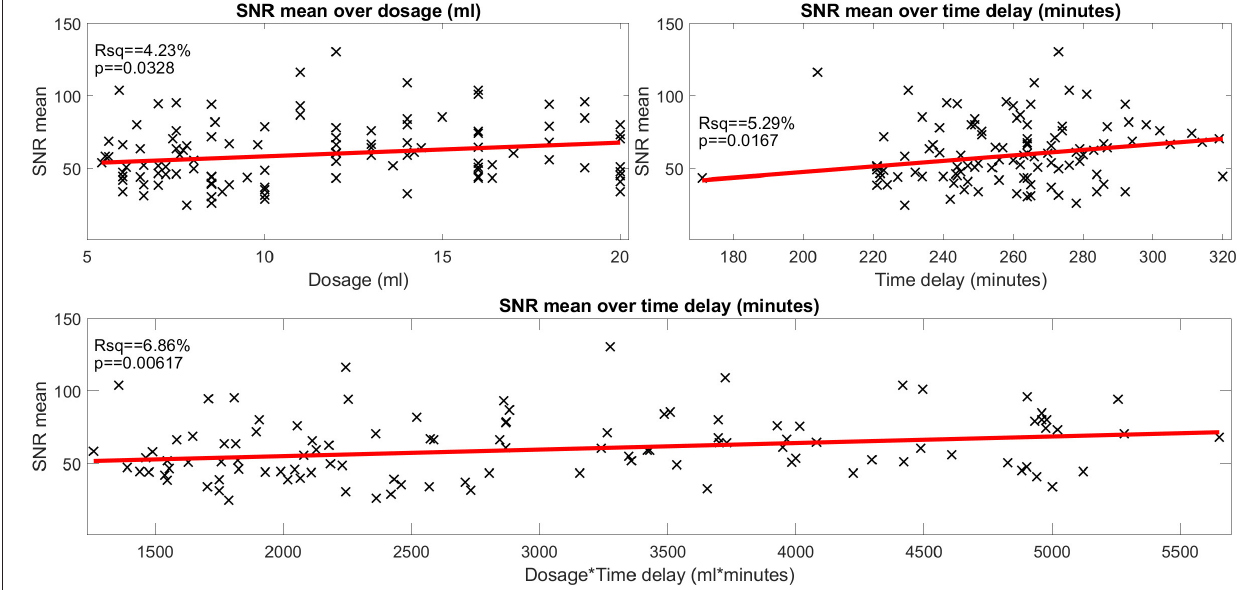
FIGURE 2 | Influence of gadolinium (Gd) dosage and Gd time delay on the signal-to-noise ratio (SNR) (belonging to question i). The scatter plot of the signal-to-noise ratio (SNR) over the gadolinium (Gd) dosage (in ml, plot in the top left), of the SNR over the time delay (in minutes, plot in the top right) and of the SNR over the interaction of Gd dosage × time delay (ml × minutes, plot in the bottom). SNR data points are plotted as black crosses and the trend lines of the fitted model are plotted as red lines. The SNR depended significantly on dosage, time delay as well as the interaction of dosage × time delay. However, the effect size was very small (4.2, 5.3, and 6.8% of explained variance, respectively). The SNR displayed here “SNR mean” is the mean of the SNRs calculated for each region of interest, i.e., the two inside the basal cochlear turn (CBT), the apex cochleae (AC), the horizontal semicircular canal (hSCC) as well as the posterior SCC (pSCC). For each region, the SNR is the mean signal divided by the standard deviation of the region labeled “air.” The left and the right ear are averaged for each region, before regions are averaged to form “SNR mean”.